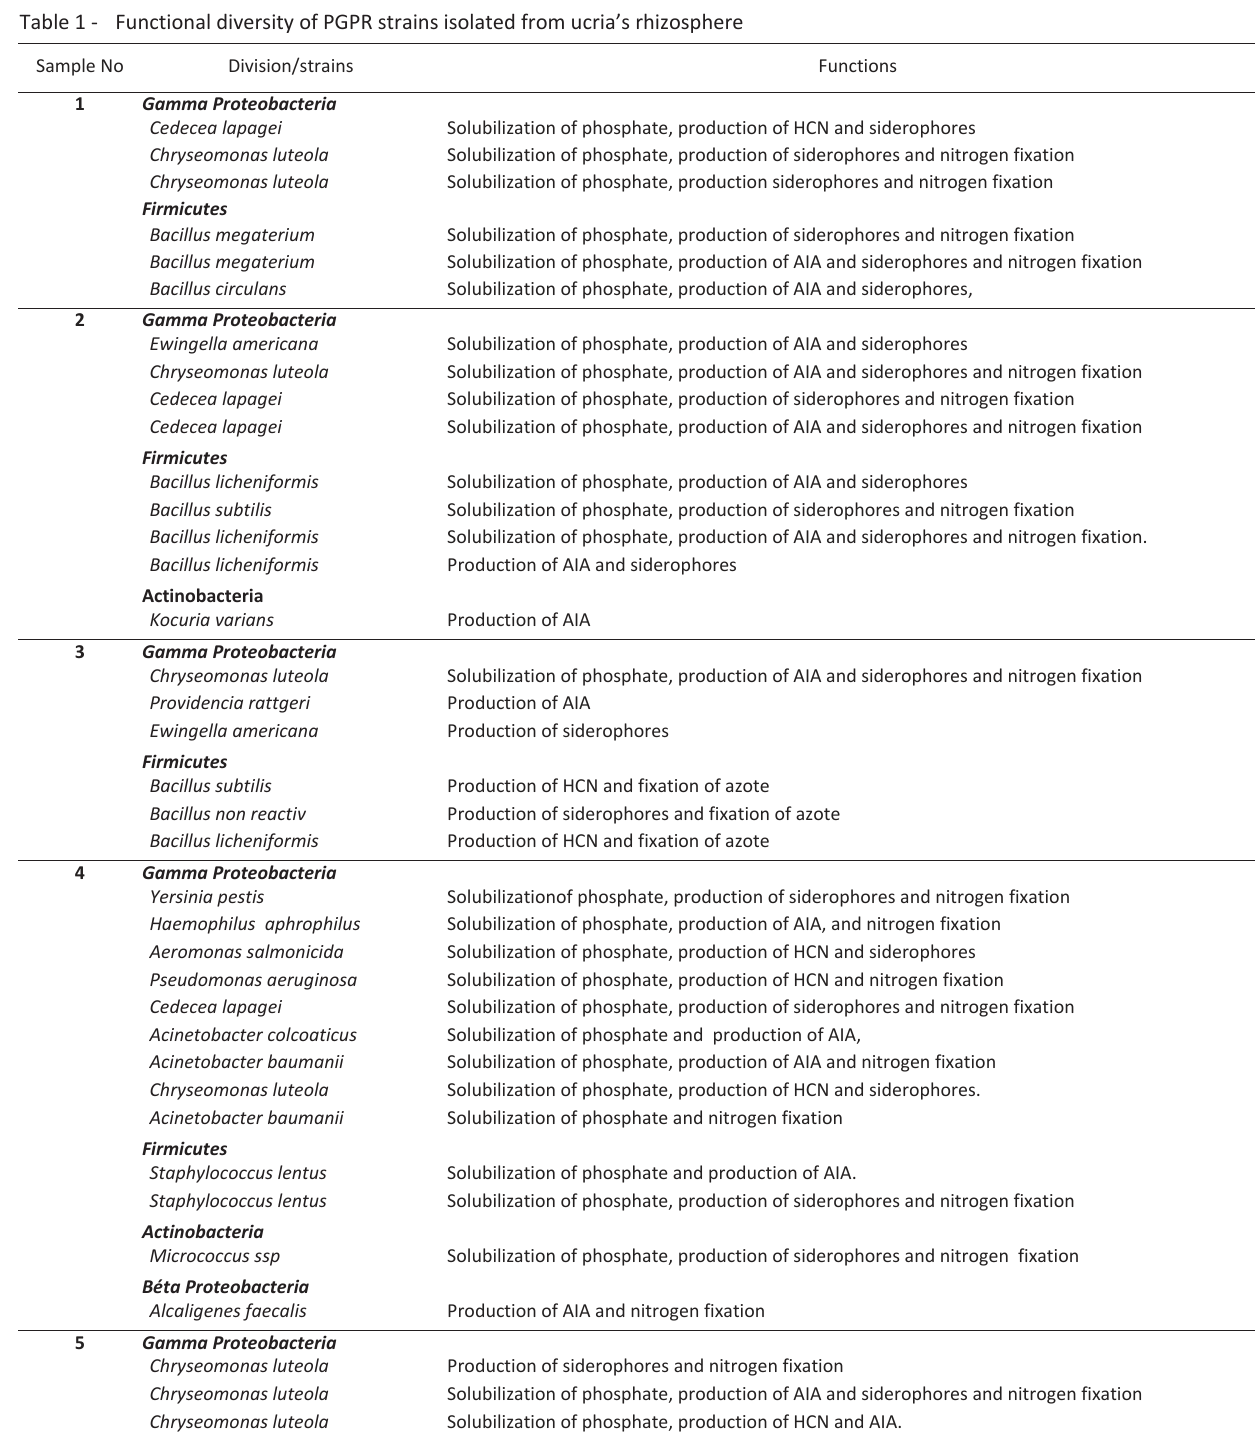
Table 1 - Functional diversity of PGPR strains isolated from ucria’s rhizosphere Sample